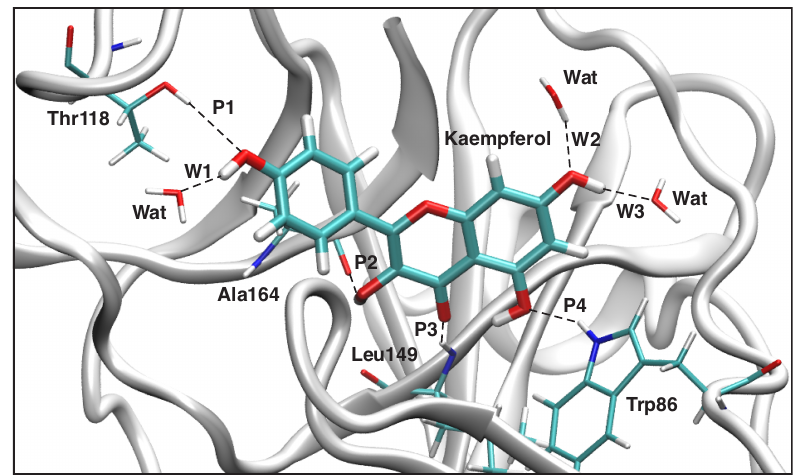
Figure 10. Optimized geometry of the Kaempferol-NS3 complex. The QM part includes Kaempferol, indicated by bold sticks; the MM part includes the NS3 protein, water molecules, and counter ions (for further details, see Supporting Information). There are eight hydrogen bonds (dashed lines) between Kaempferol and the Thr118, Ala164, Leu149, and Trp86 residues (thin sticks) of NS3, and between Kaempferol and the three water molecules in the binding pocket and one intramolecular hydrogen bond; see also Figure 9. (Number of QM atoms: 31, total number of atoms: 3338). ω B97X- D/6-31G(d,p)/AMBER level of theory. Table 4. The local mode parameters of the hydrogen bonds between Kaempferol and NS3 from the QM/MM calculations, the ω B97X-D/6-31G(d,p)/AMBER level of theory for the calculation in the protein, and the ω B97X-D/6-31G(d,p) level of theory in the gas phase. d k a ω H-Bond